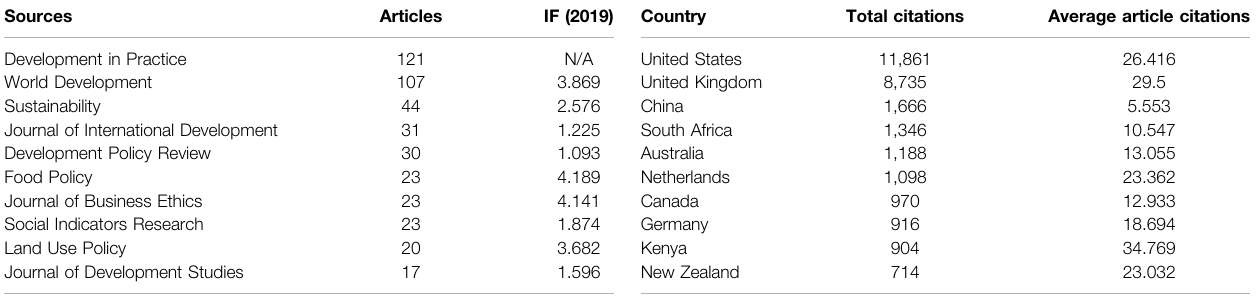
TABLE 2 | Top 10 sources of publications. Sources